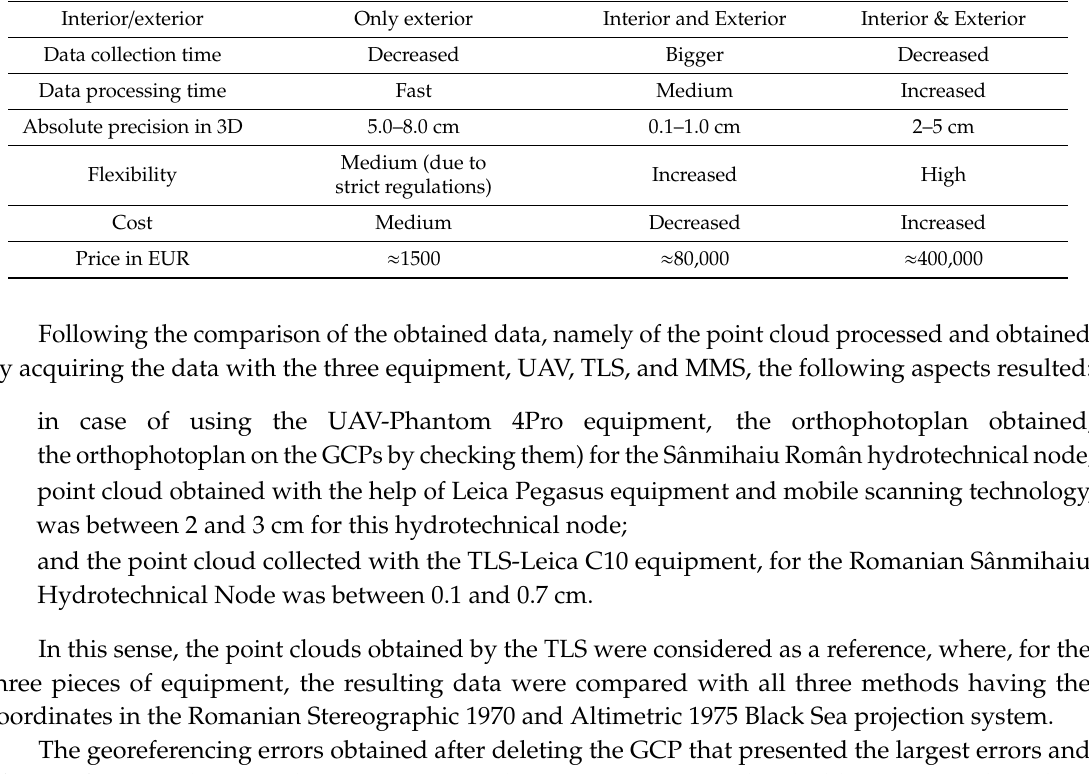
Table 3. Georeference errors of UAV images on GCP for NH Topolov ă t